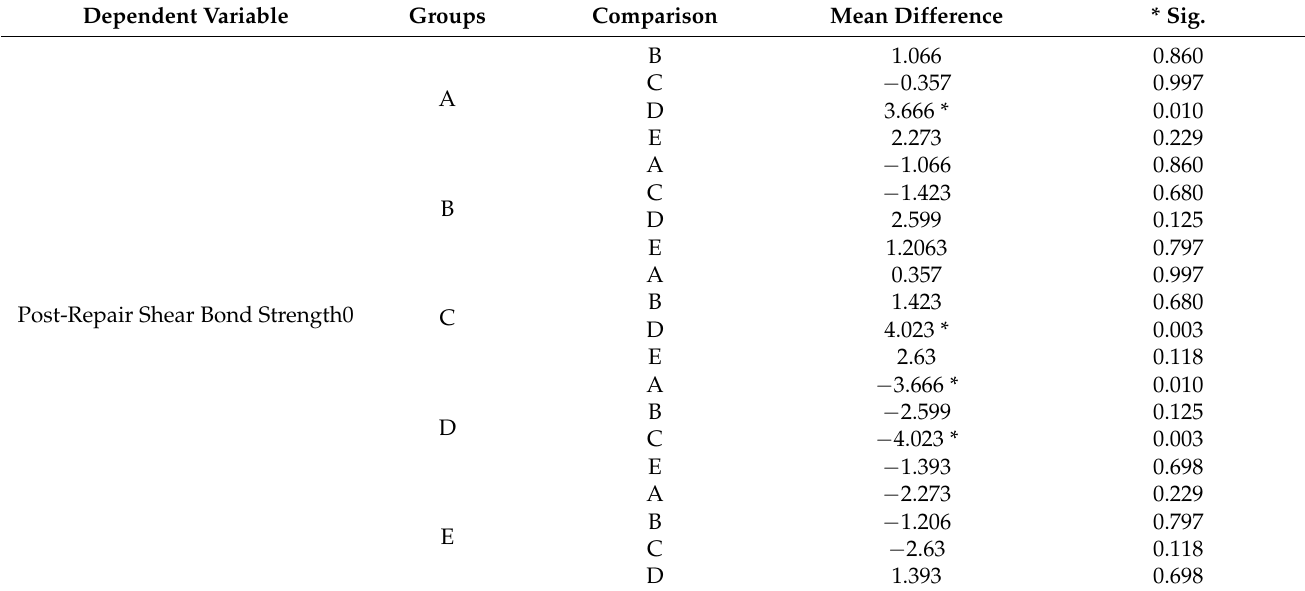
Table 5. Multiple comparisons and mean differences of the shear bond strength (MPa) after the ceramic repair by Post Hoc Tukey HSD